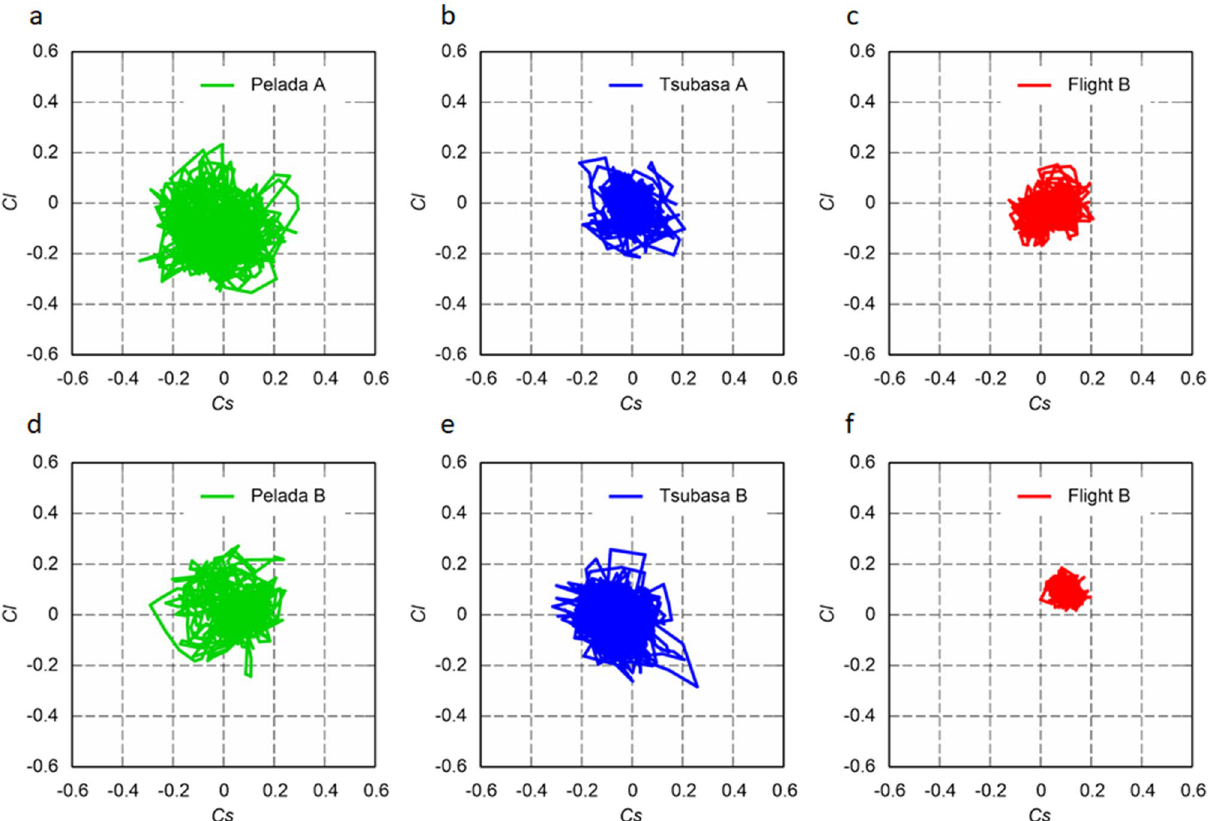
Figure 6. Scatter plots of the coefficients for the side ( Cs ) and lift ( Cl ) forces of Flight, Tsubasa, and Pelada: ( a – c ) symmetric and ( d – f ) asymmetric orientations in the supercritical regime (initial ball speed of 30 m/s; Re = 4.2 × 10 5